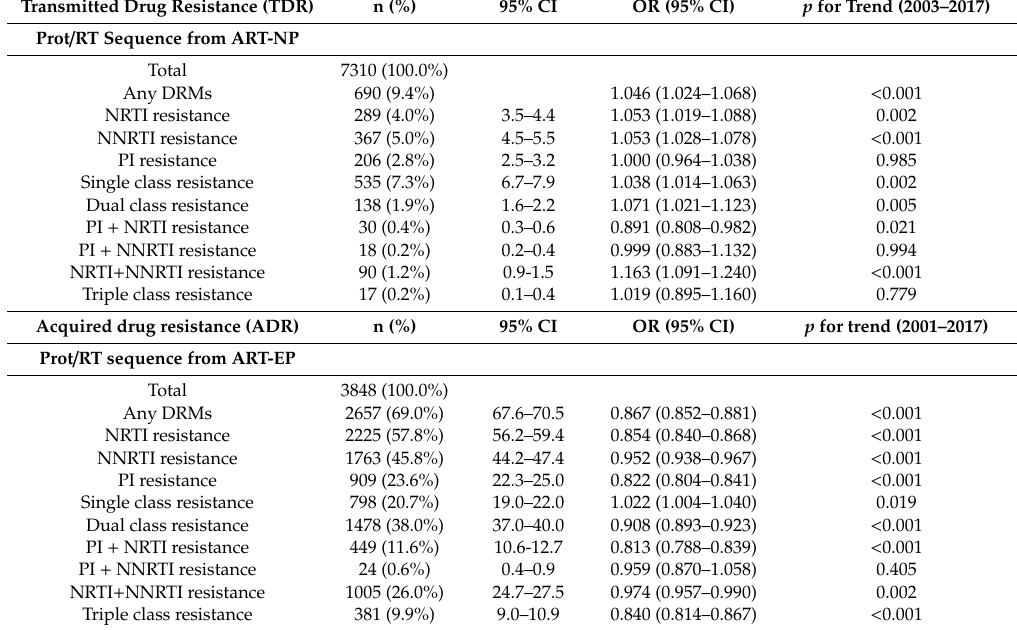
Table 2. Proportion of transmitted drug (TDR) and of acquired drug resistance (ADR) between 2001 and 2017. ART-NP, antiretroviral-naïve patients; ART-EP, antiretroviral-experienced patients; P-value for trend of TDR between 2003 and 2017 and of ADR between 2001 and 2017. Prot, protease; RT, reverse transcriptase; DRM, drug resistance mutations; NRTI, nucleotide reverse transcriptase inhibitors; NNRTI, non-nucleotide reverse transcriptase inhibitors; PI, protease inhibitors; CI, confidence interval; OR, odds